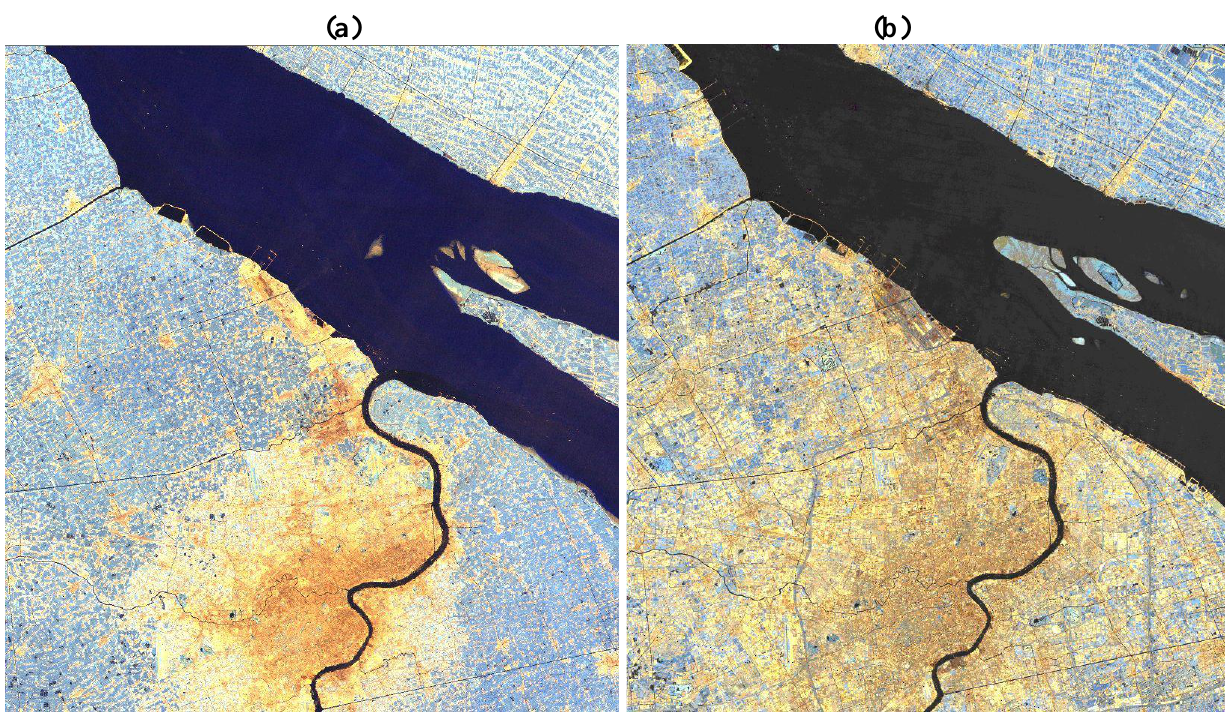
Figure 1. The growth of urban regions over Shanghai, China. (a) is based on Landsat TM for year 1989, and (b) is for Year 2008 from Landsat ETM+. Rural is generally blue, water is black, urban is gold. Data is using Near-to-mid-infrared